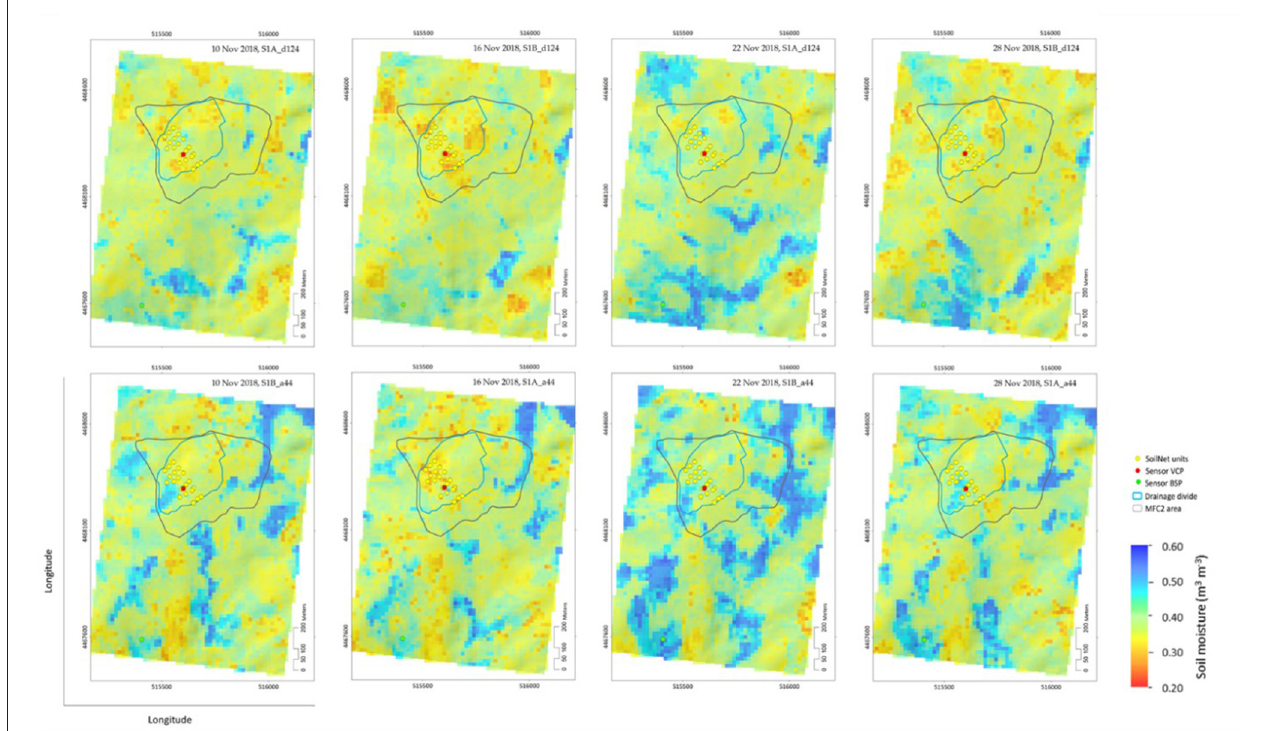
FIGURE 4 | Spatiotemporal patterns of predicted near-surface soil moisture ( θ , m 3 m − 3 ) in the morning (upper row) and in the afternoon based on SAR parameters only ( θ NovSAR ). The pixel size is 17 × 17m. White pixels refer to no data